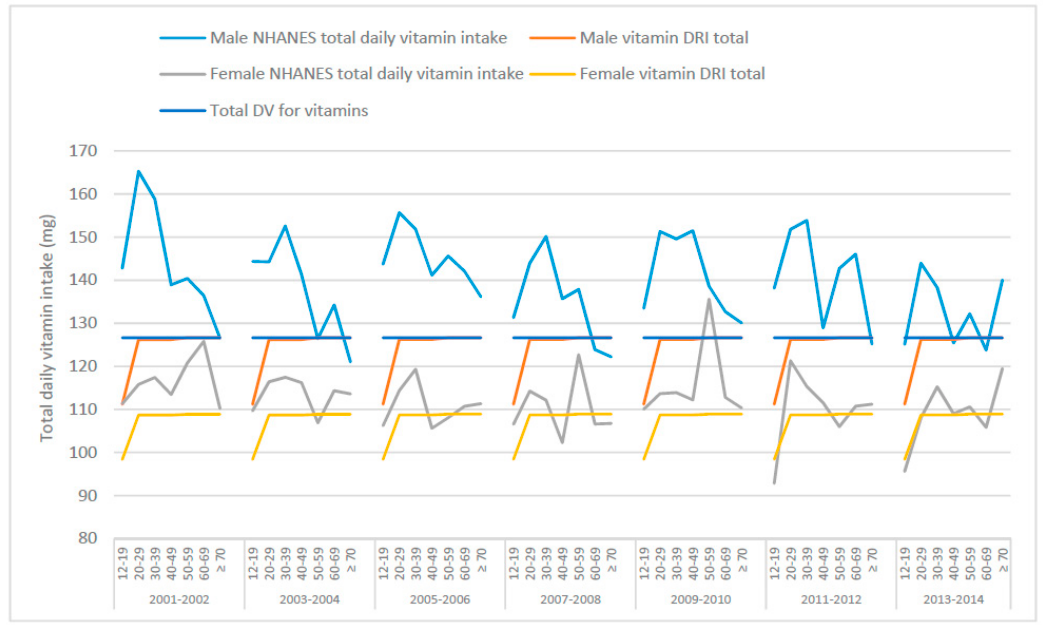
Figure 2. Total mean daily vitamin intakes from food across various age groups, derived from National Health and Nutrition Examination Survey (NHANES) 2001–2014 data, the total Dietary Reference Intakes (DRI) and the total Daily Value (DV) for males and females.